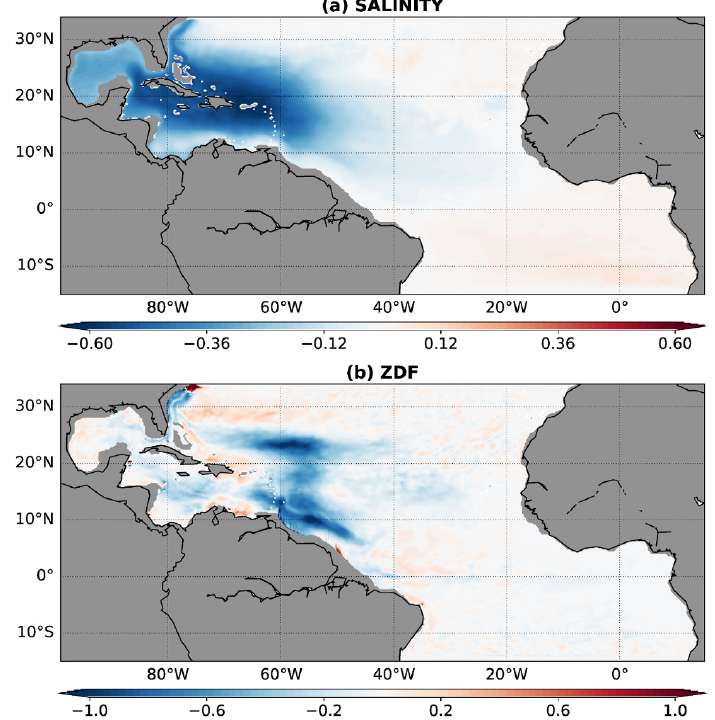
Figure 9. Time-mean salinity anomalies averaged over the layer 30–160 m: ( a ) salinity (PSU); ( b ) turbulent vertical diffusion of salinity (ZDF, 10 − 3 PSU/day). The considered period is